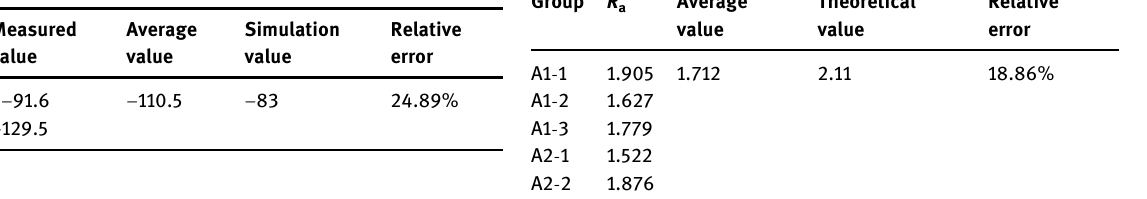
Table 5: The comparison and analysis of roughness ( unit: μ m